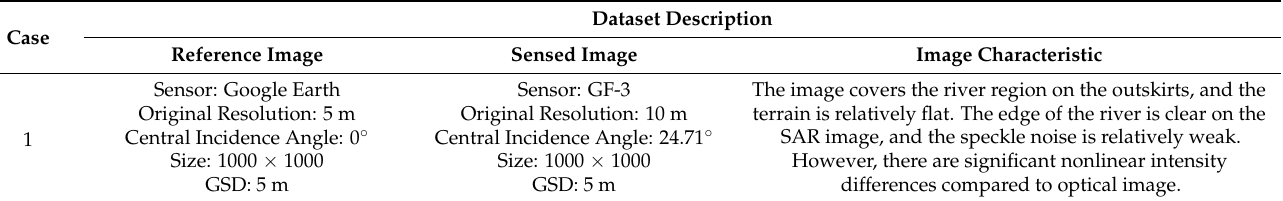
Table 1. Optical and SAR images.